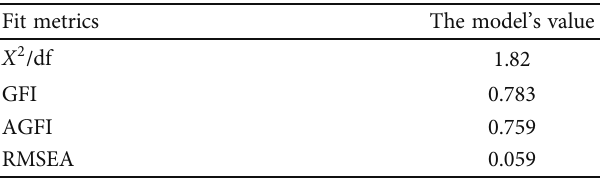
Table 5: The results of fi t testing of the proposed